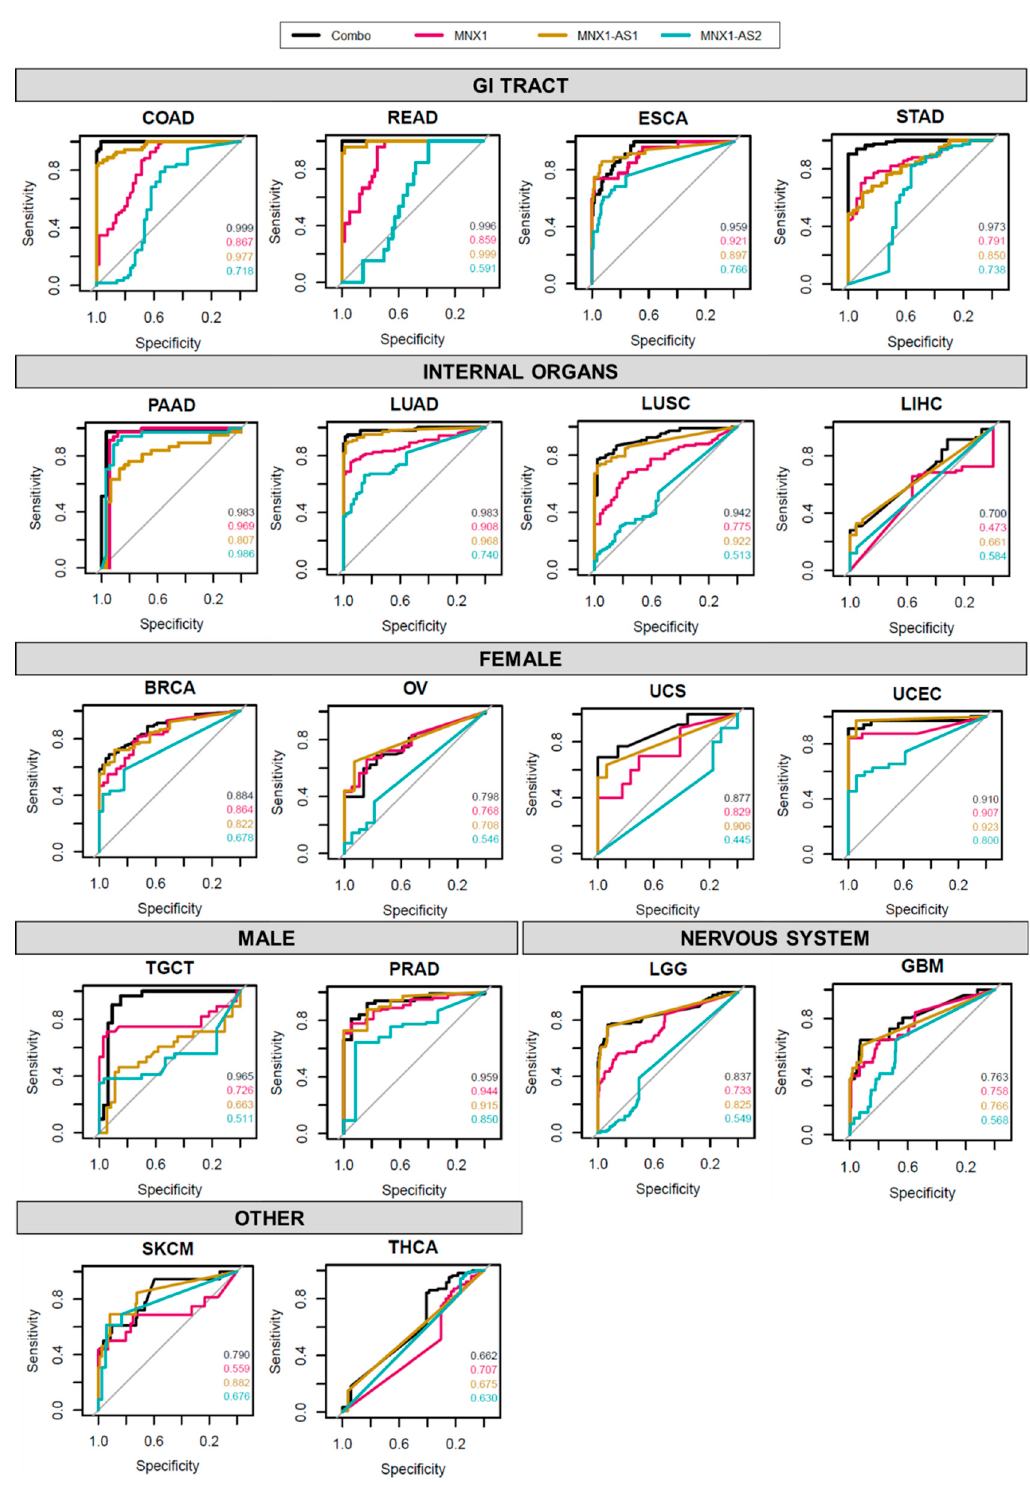
Figure 2. ROC analysis of MNX1, MNX1-AS1, and MNX1-AS2 expressions as diagnostic evaluators. Each plot represents the ratio of sensitivity and specificity of the discriminatory power for each gene and their combination. The AUC values for each gene and combination are shown on the bottom right corner, with values closer to 1 indicating a higher performance in discerning normal vs. tumour samples.